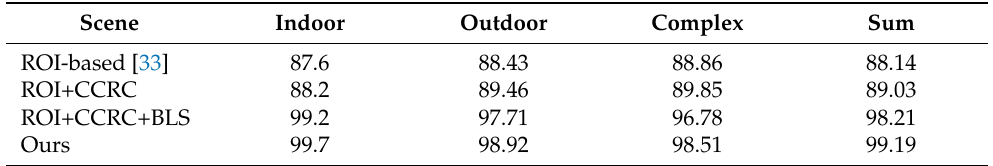
Table 3. Quantitative comparison between character recognition methods. The last row ROI+CCRC+TMPP+BLS is the proposed method for ALPR